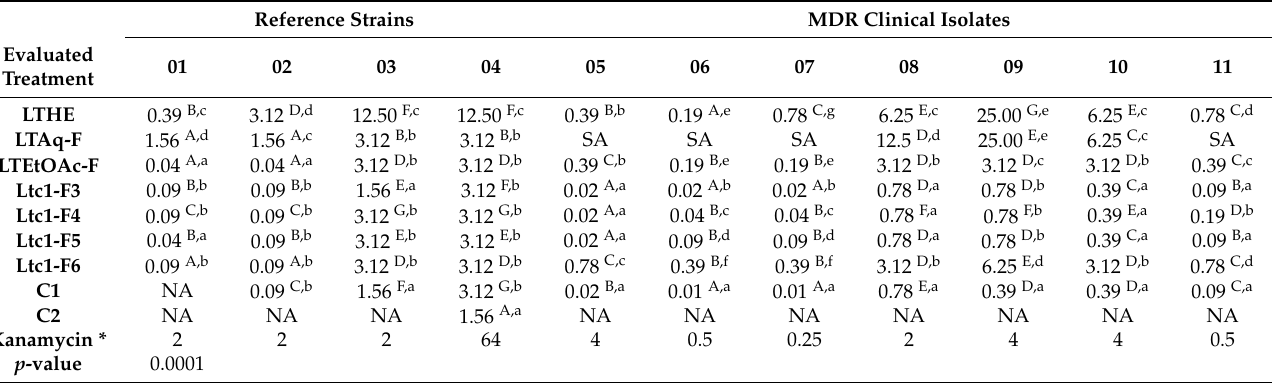
Table 2. Minimal inhibitory concentrations of L. tridentata against evaluated bacteria